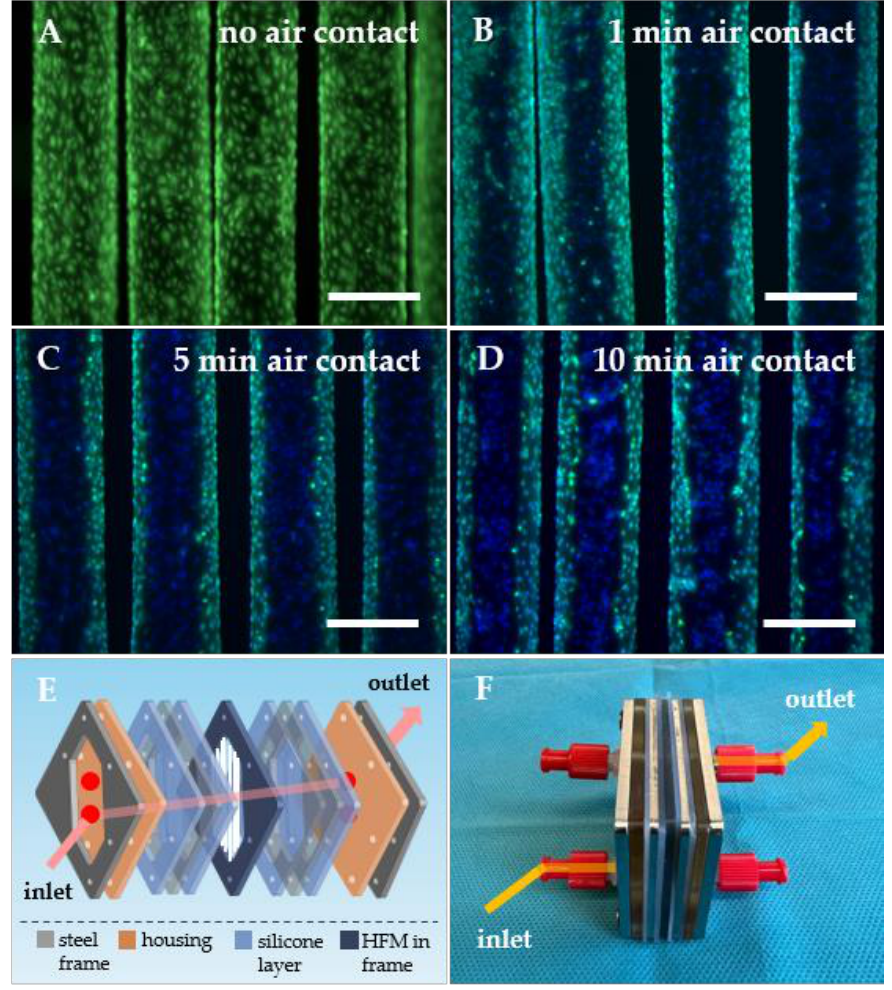
Figure 1. EC monolayer established on HFMs by standardized in vitro protocol was adversely affected by air contact during transfer for MOx assembly. Fluorescence microscopy for the detection of calcein-stained, viable ECs (green, A – D) covering the HFM surface without air contact ( A ) and after air exposure for 1 min ( B ), 5 min ( C ) or 10 min ( D ). Nuclei were counterstained with Hoechst 33342 (blue), scale: 400 µm. The exploded view illustrates the various layers of the model oxygenator (MOx) ( E ), supplemented by a photo ( F ); respective arrows demonstrate the direction of the cell suspension’s injection through the MOx.